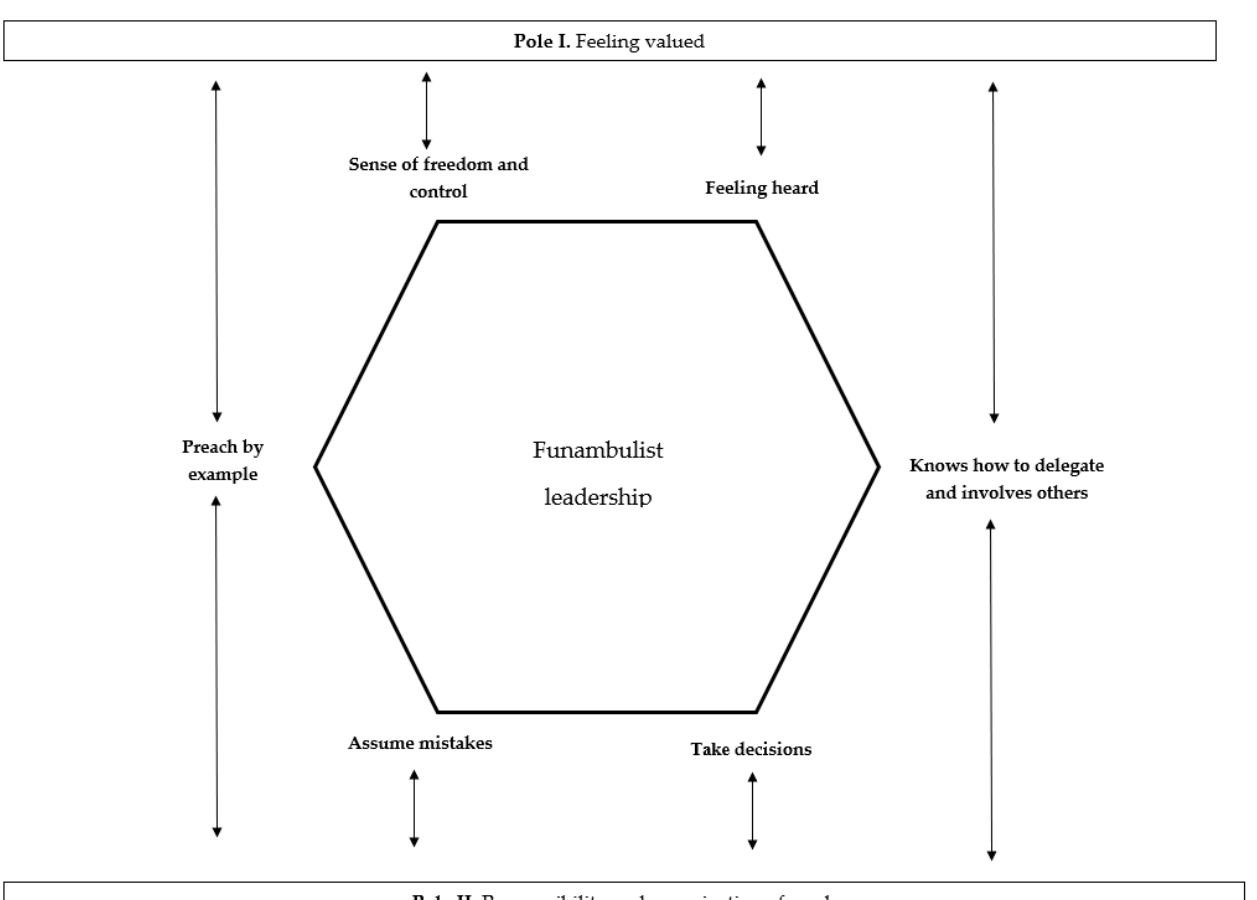
Figure 1. Outlining the funambulist leader: attitudes, perceptions and assumptions. Note: own elab- oration.